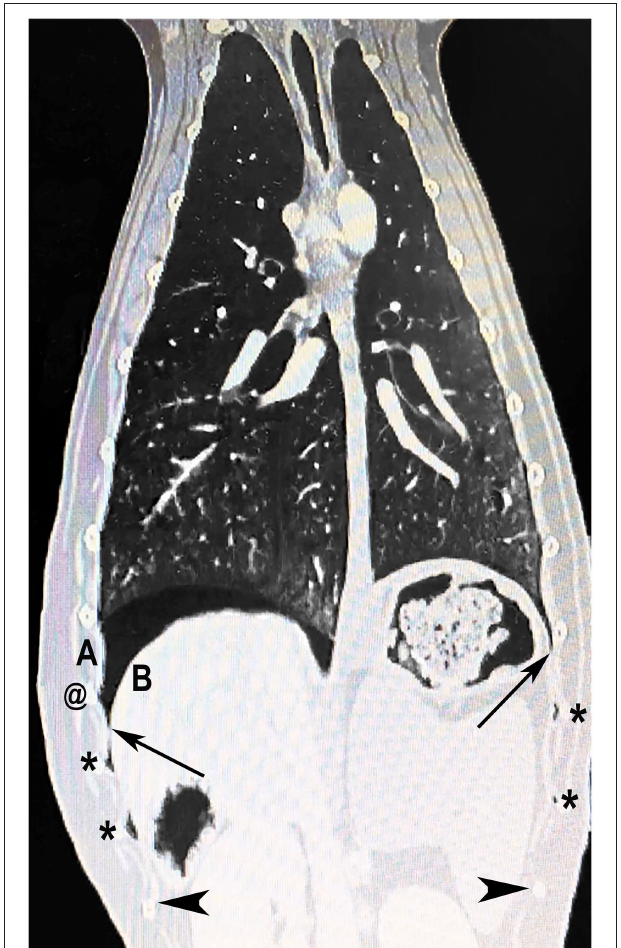
FIGURE 5 | Hypothesized mechanism of asynchronous and double curtain signs. Computed tomography image of a dog with spontaneous pneumothorax showing free air (asterisks) trapped in the costophrenic recess. Cranial and caudal borders of the costophrenic recess are indicated by long arrows and arrowheads, respectively. An asynchronous curtain sign occurs when there is free air cranial to the costophrenic recess (cranial to long black arrows); during inspiration, the negative pressure created by expansion of the thorax pulls the costal diaphragm (B) laterally until it contacts the ribcage (A) and pushes free air cranially, while contraction of the diaphragm pushes abdominal contents caudally. A double curtain sign occurs when the ultrasound probe is placed between two pockets of air (between two asterisks) creating two visible vertical edges (air/soft tissue interfaces). A double curtain sign can also appear as a result of air becoming trapped in the costrophrenic recess during inspiration. For example, if negative pleural pressure pulls the costal diaphragm (B) into contact with the thoracic wall (A), air may become trapped at the @ symbol, which would create a double curtain sign when the probe is placed between the cranial asterisk and the @ symbol. The leading edge of the double curtain sign in this situation may also be asynchronous, moving cranially during inspiration as the diaphragm continues to come in contact with the chest